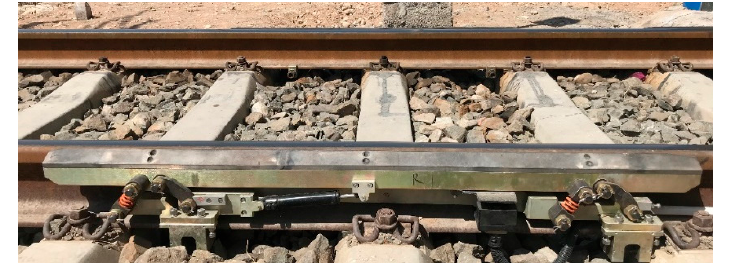
Figure 15. The photo of the installed parallelogram mechanism.